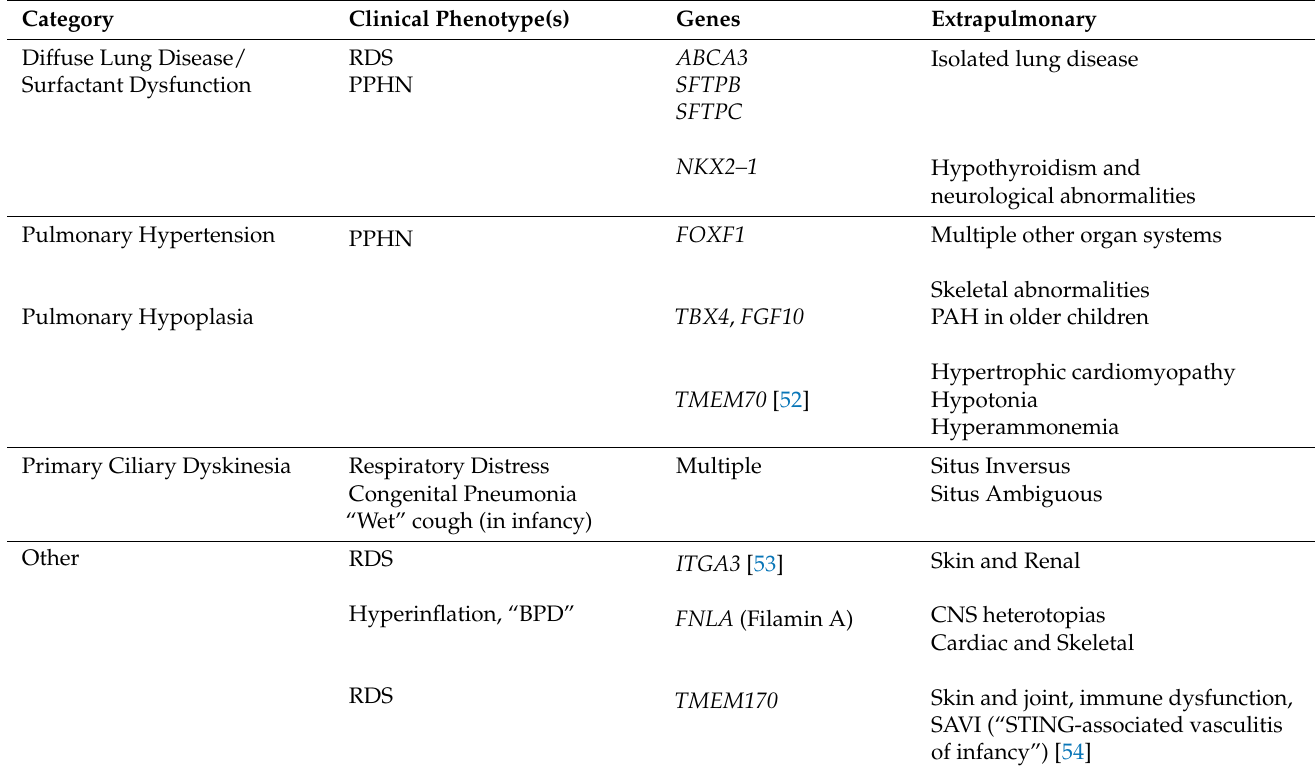
Table 2. Pulmonary phenotypes, related genes and extrapulmonary